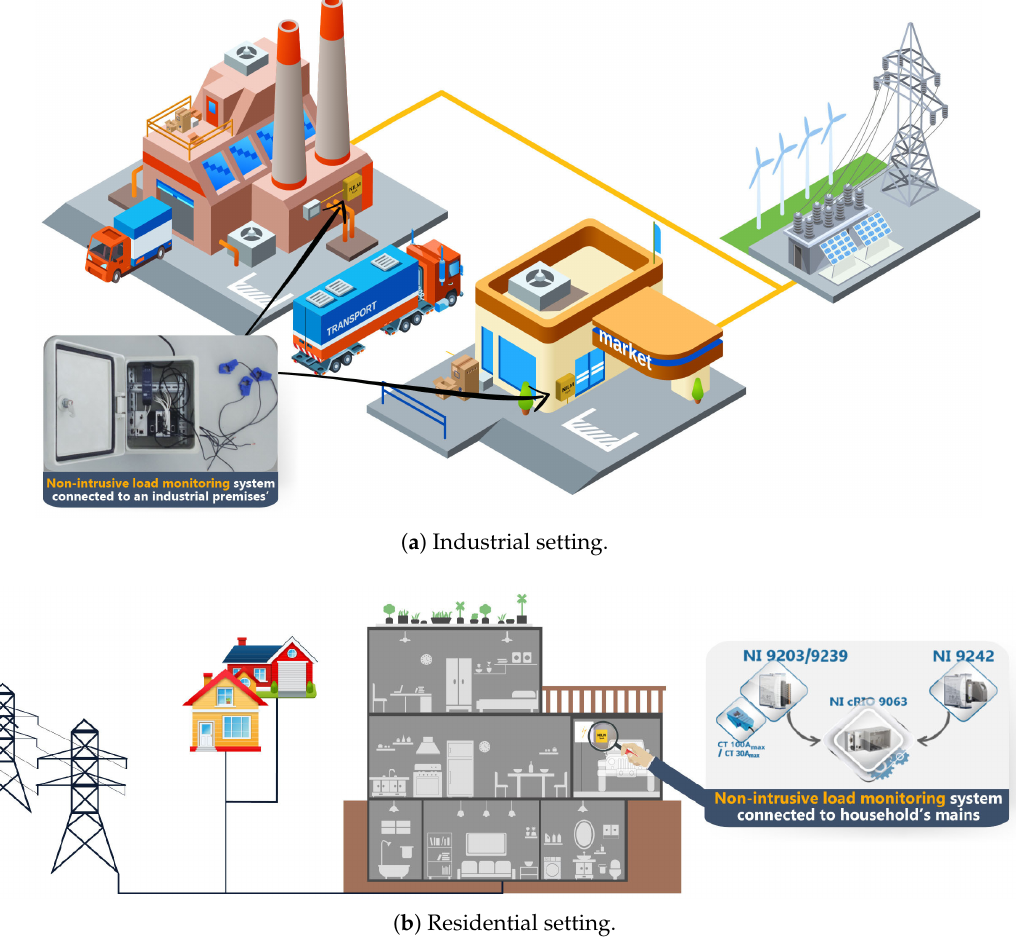
Figure 1. Illustrations of the Integrated Monitoring and Processing Electricity Consumption (IMPEC) systems installed in different